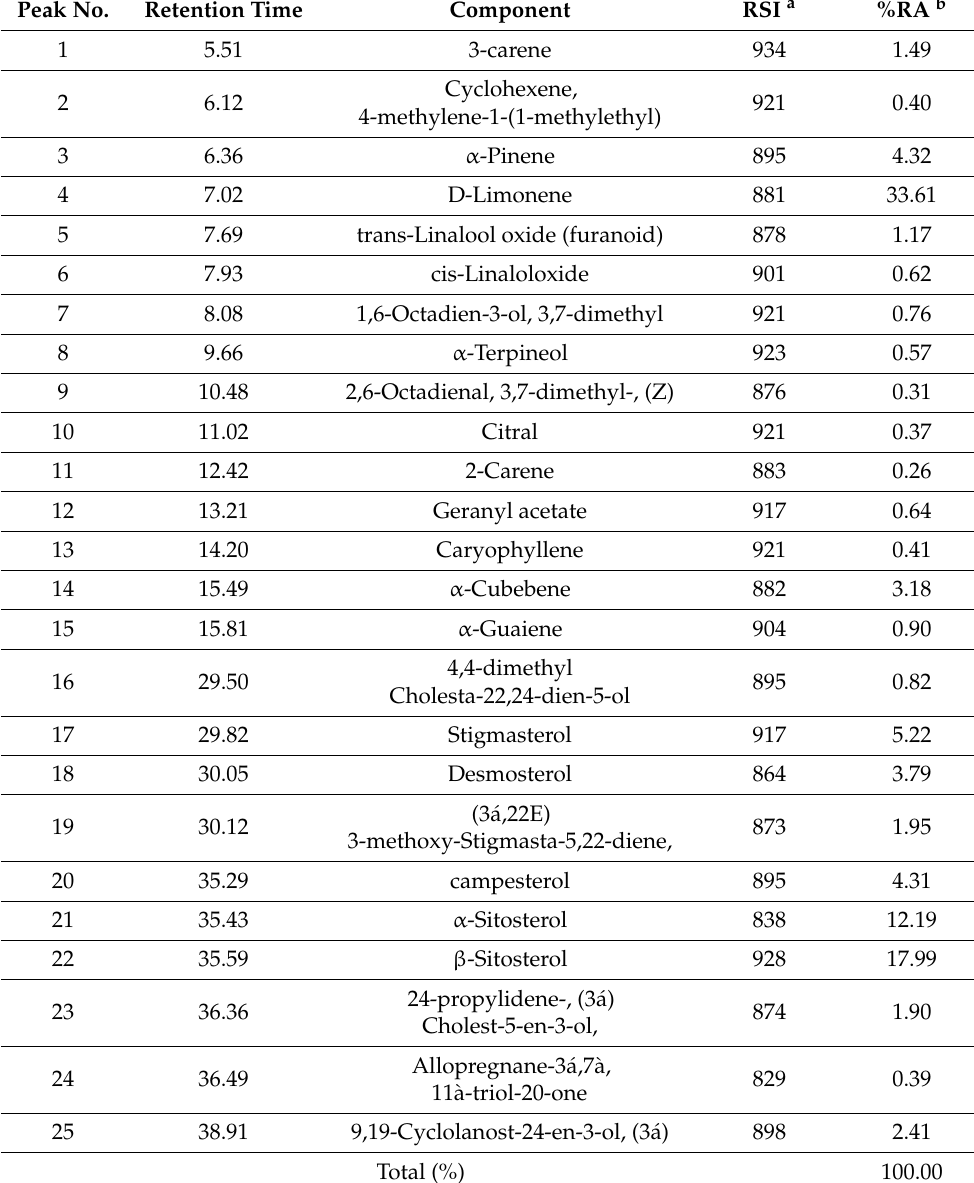
Table 1. Chemical configuration of Citrus maxima essential oil (CMEO). Peak